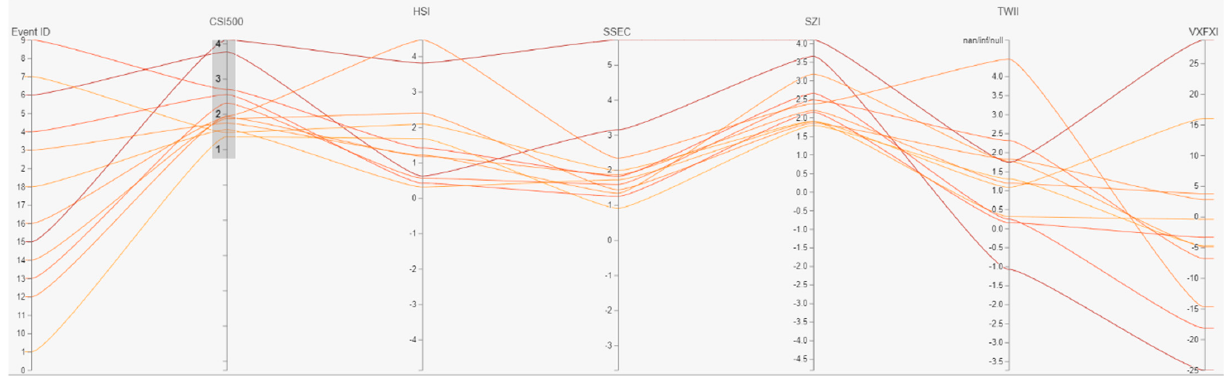
Figure 9. Major social events and stock market trends in 2020 in China (line).